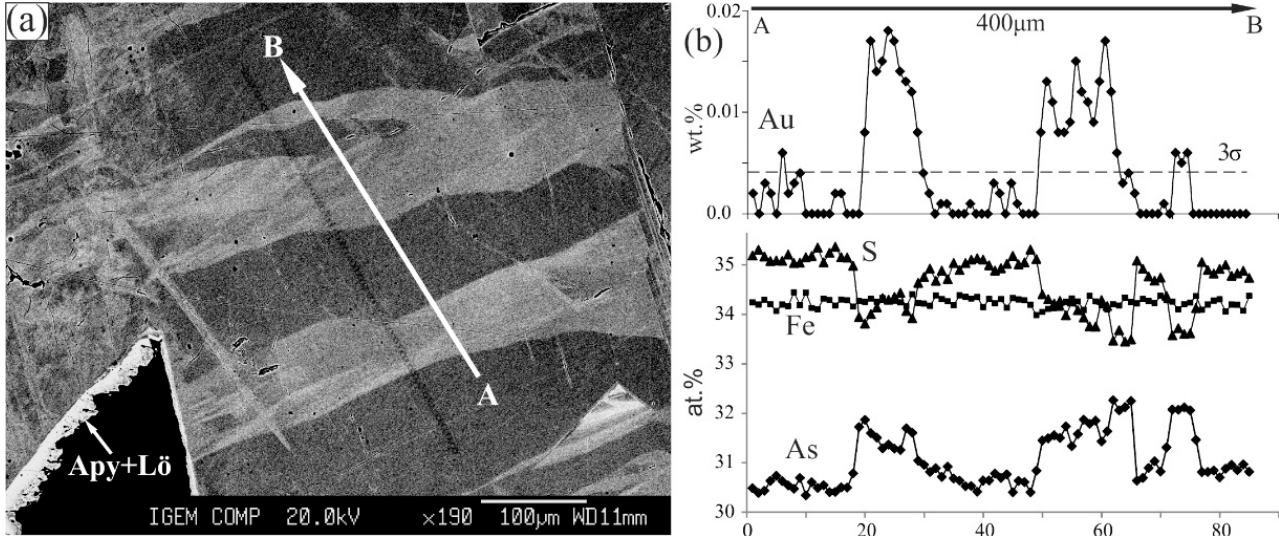
Figure 7. Compositional zoning of the S-rich arsenopyrite Apy-1, EPMA. ( a ) Zonal structure of arsenopyrite with the outer rim of As-rich arsenopyrite with microinclusions of löllingite, BSE image. ( b ) Distribution of C Au (wt%) and S, Fe and As (at%) along the profile (A–B). C Au was measured by precision microprobe analysis with detection limit 45 ppm.